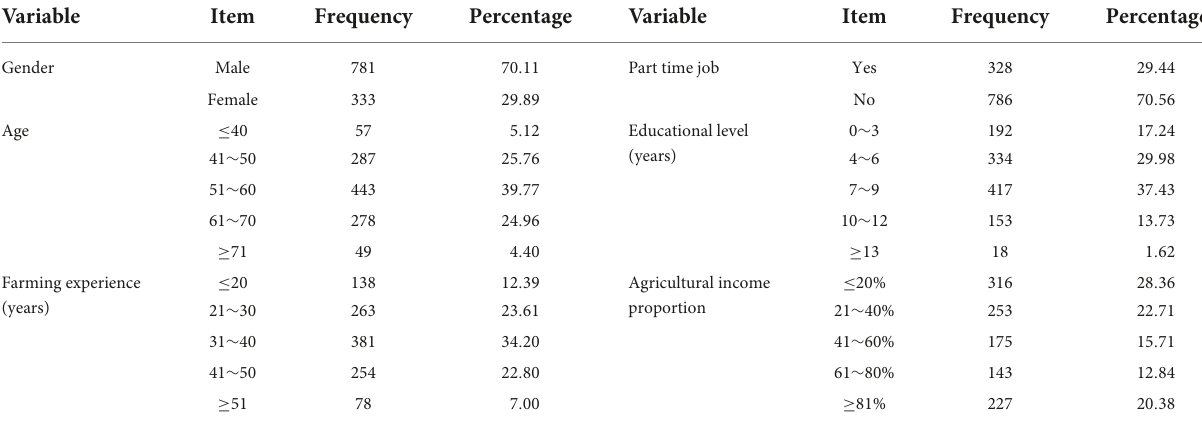
TABLE 2 Basic characteristics of the surveyed rice farmers.